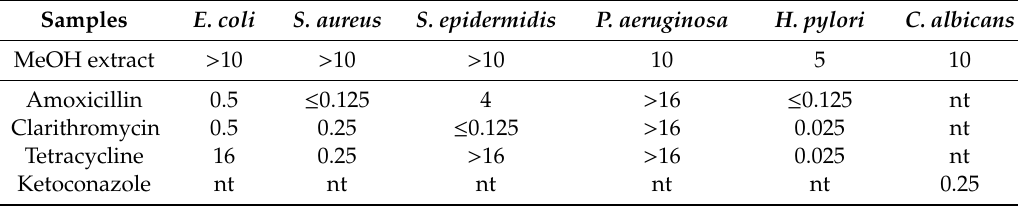
Table 1. Antimicrobial activity of P. russeliana methanol extract (MICs in mg / mL). Samples E.